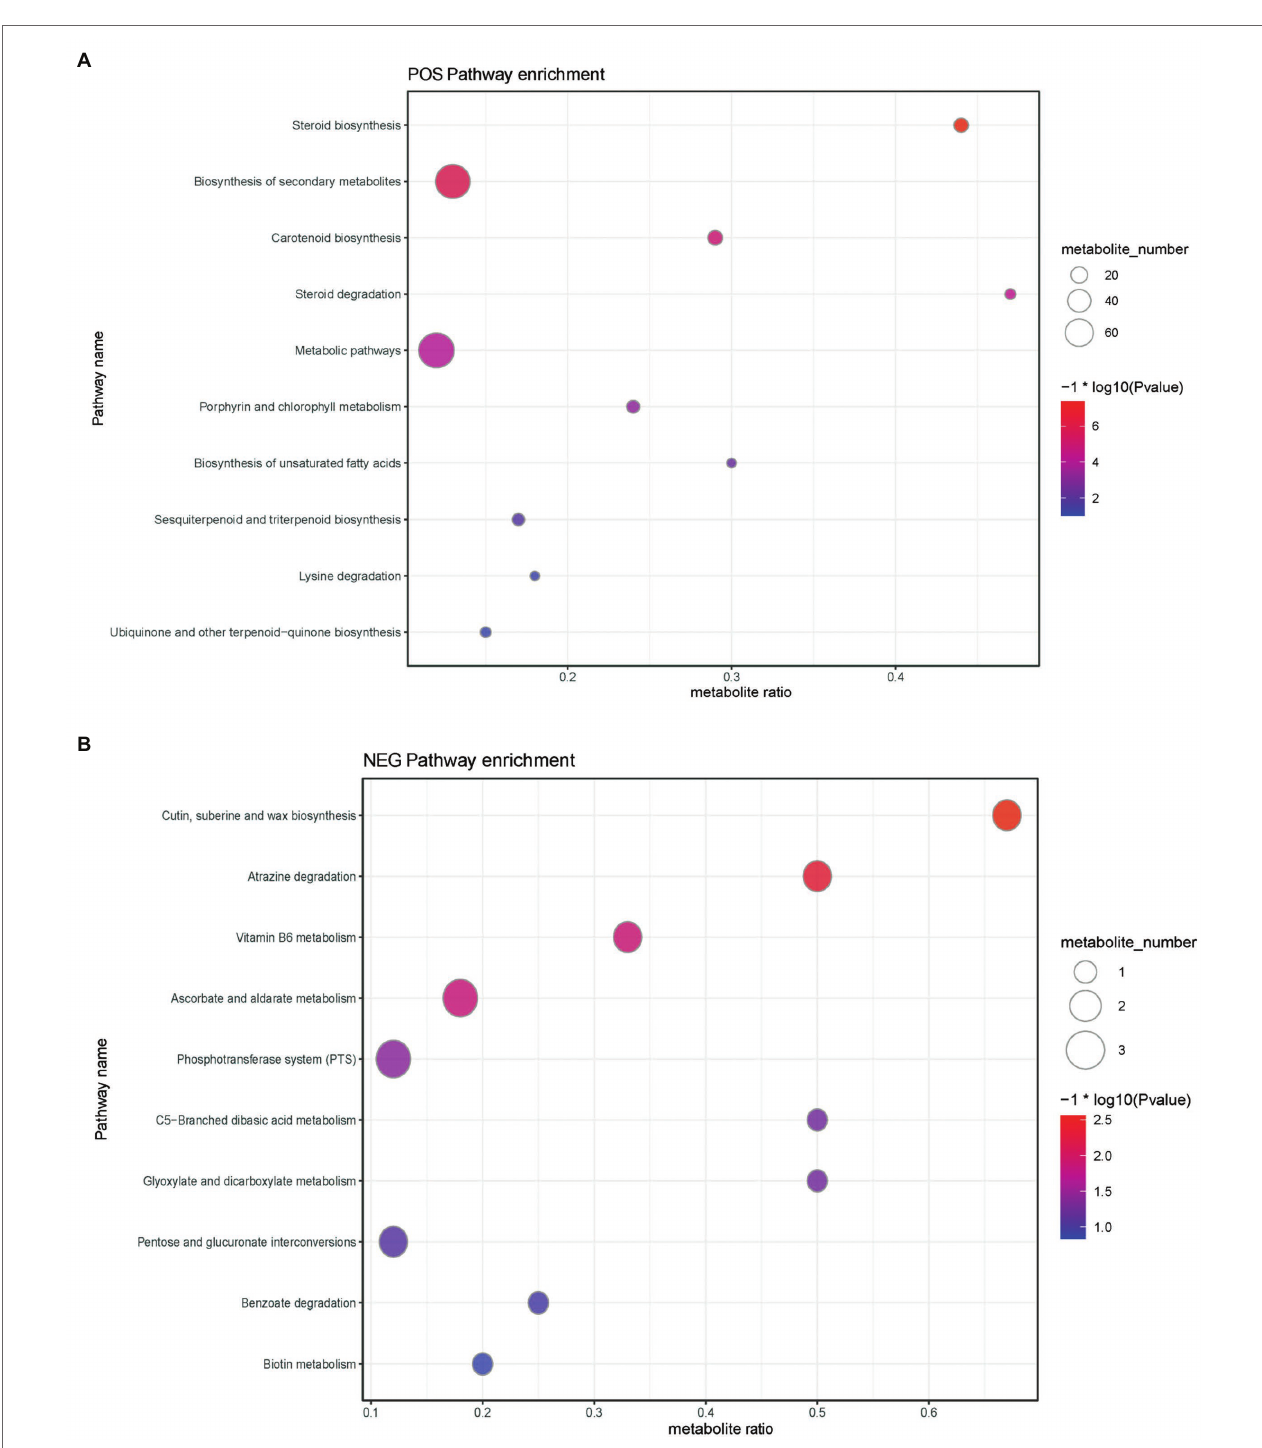
FIGURE 6 | Buddle diagram of KEGG pathway enrichment analysis of differential metabolites. The x axis (Rich Factor) represents the ratio of the number of differential metabolites annotated to the pathway to all the metabolites annotated to the pathway. The higher the value, the higher the degree of enrichment of differential metabolites in this pathway. The color of the point represents the value of p value of the hypergeometric test, and the smaller the value is, the greater the reliability of the test and the more statistically significant it is. The size of the dots represents the number of differential metabolites annotated to the pathway, and the larger the point, the more differential metabolites in the pathway. (A) Positive ion pattern analysis and (B) negative ion pattern